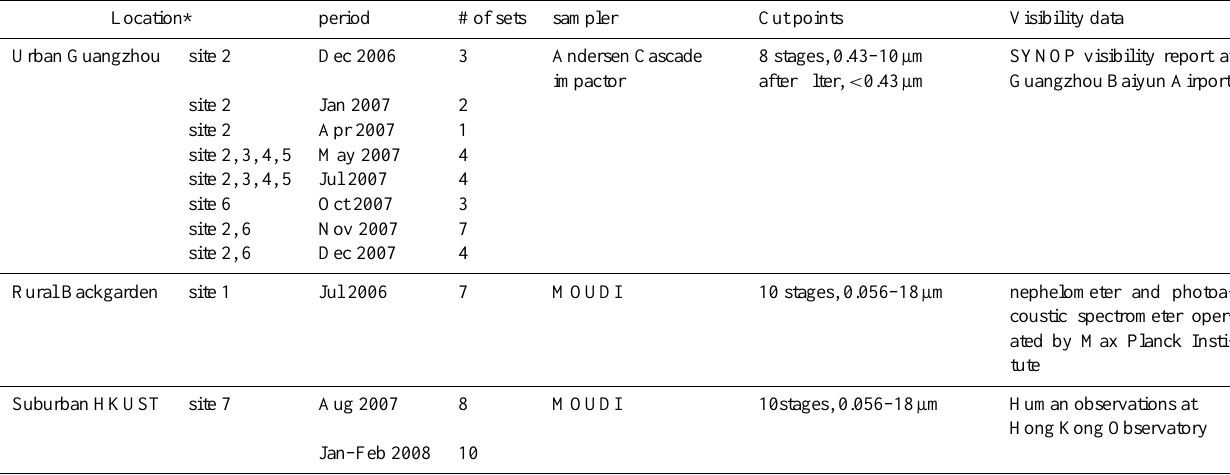
Table 1. Size-segregated aerosol samples collected in selected urban, suburban and rural locations in the pearl river delta region.